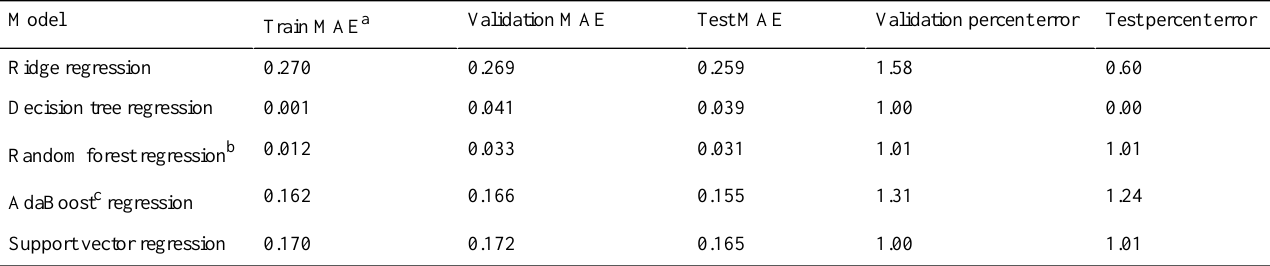
Table 5. Optimal MAE and median percent error values for the in-distribution validation method.